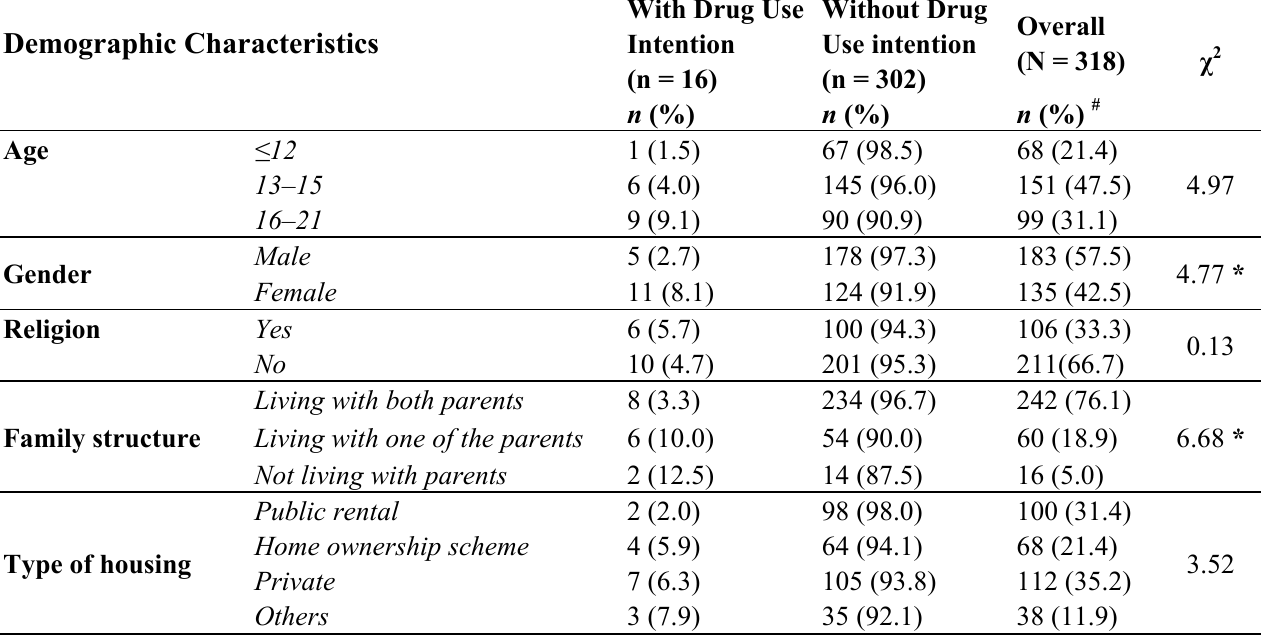
Table 1. Demographic Characteristics and Drug Use Intention (N =